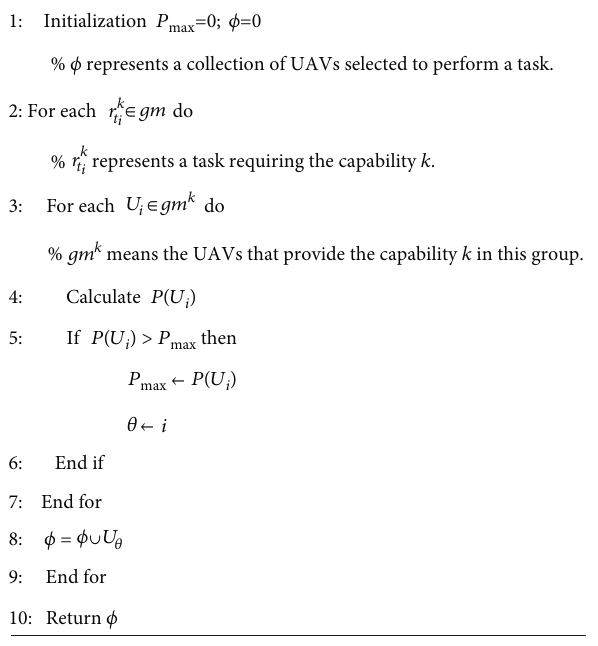
Algorithm 2: Task assignment algorithm within a UAV group